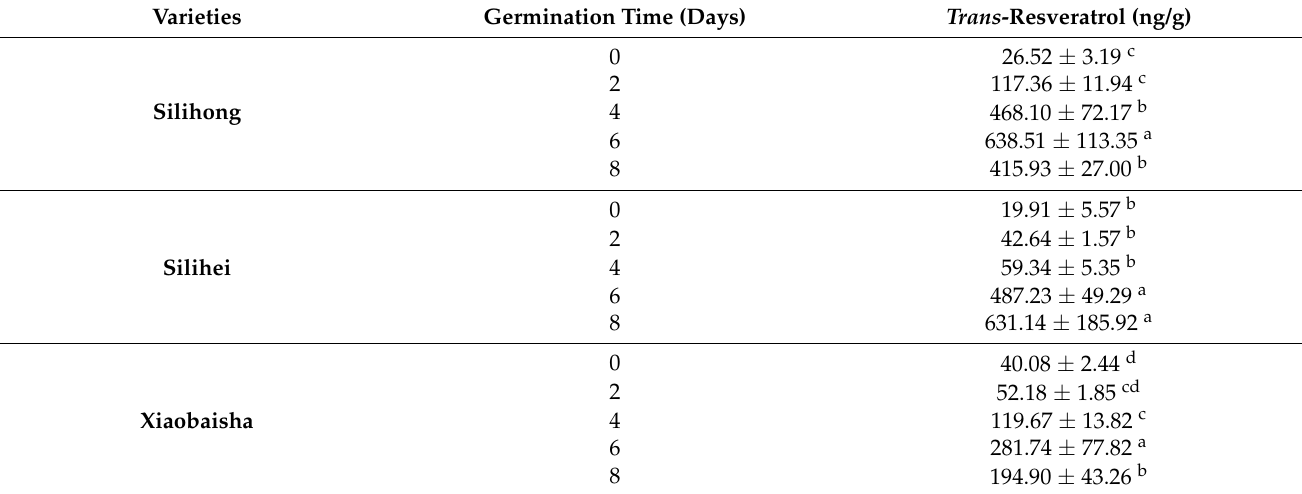
Table 1. Trans -Resveratrol content of different kinds of peanuts during